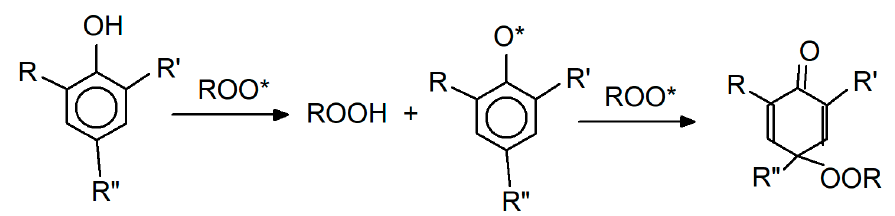
Figure 3. Mechanism of action of phenolic antioxidants.